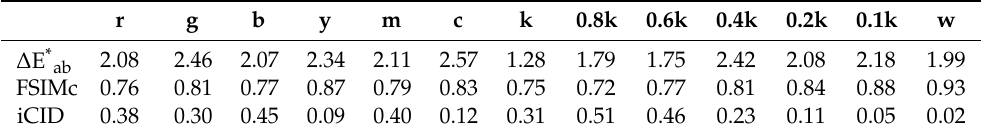
Table 5. Comparison of overall relative ∆ E * ab , FSIMc, and iCID values of all test